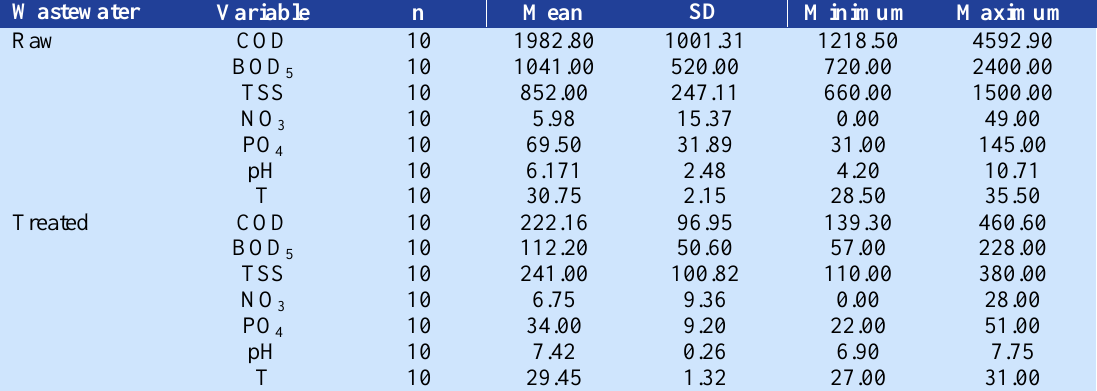
Table 2. Quality of raw and treated wastewater samples collected from Pelareh Dairy Industry